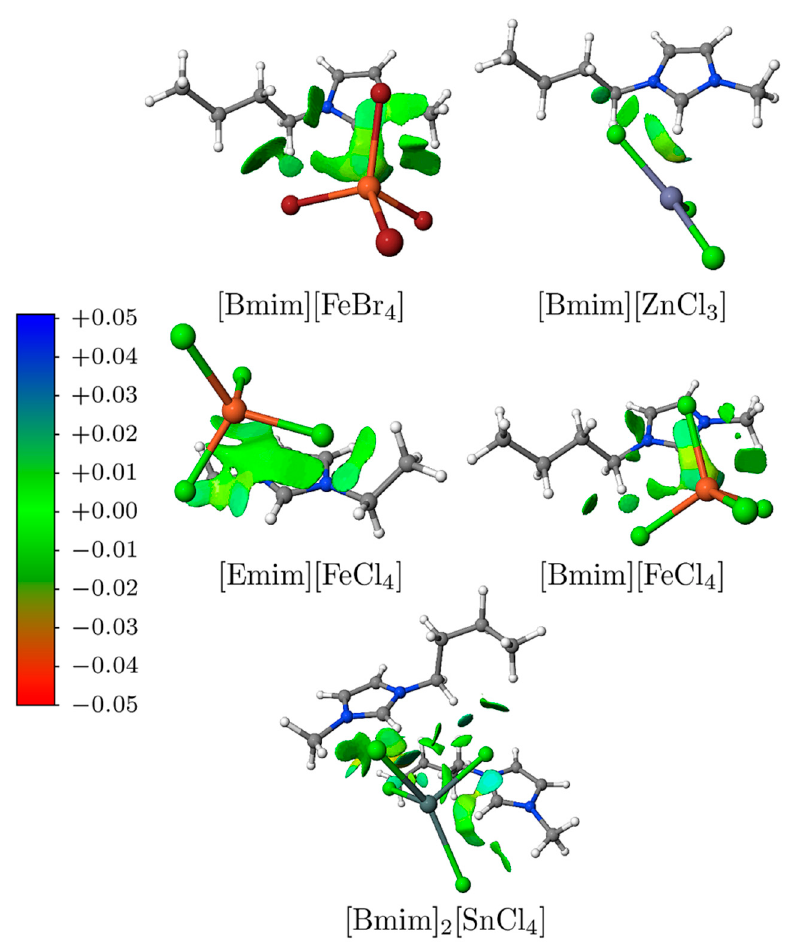
Figure 6. NCIPLOT gradient isosurfaces (0.3 a.u.) for the MILs studied in this work. The colour scales over the range − 0.05 to +0.05 a.u.